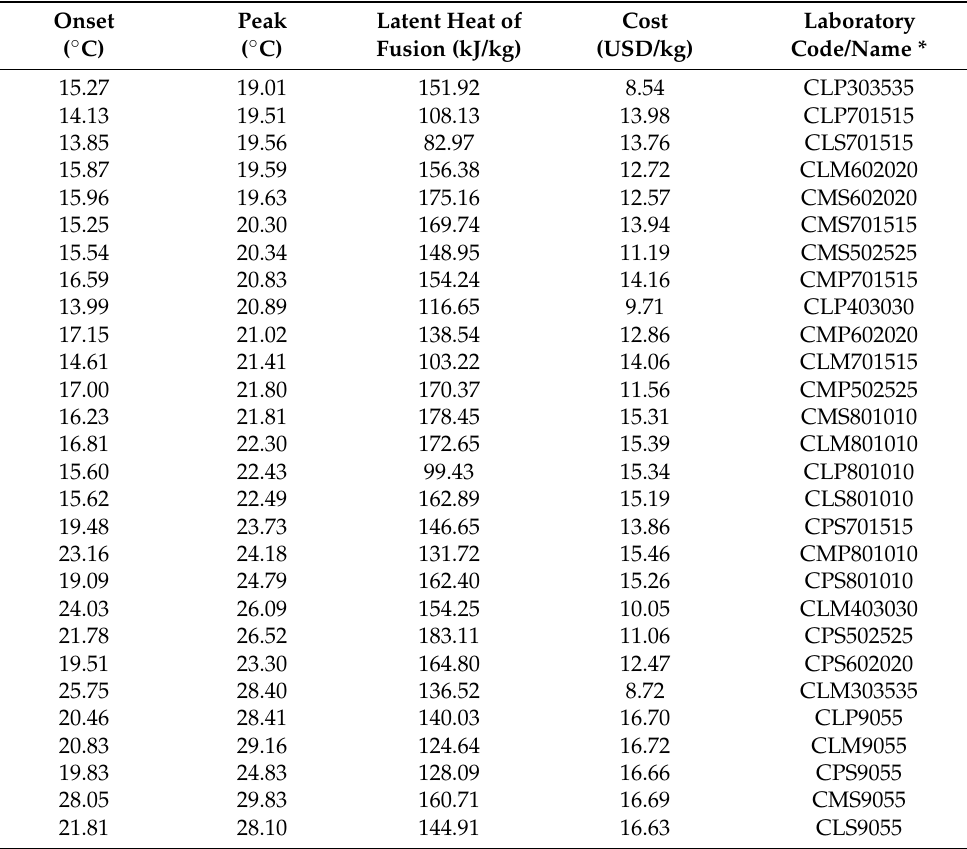
Table 2. Thermophysical properties of the obtained